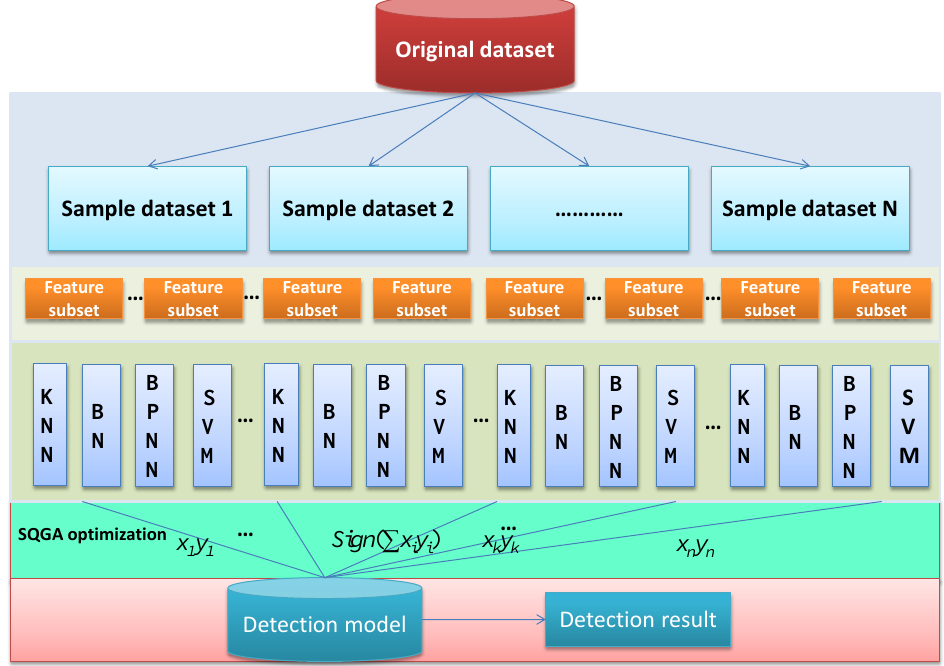
Figure 4. Flow chart of SQGA optimized ensemble learning.